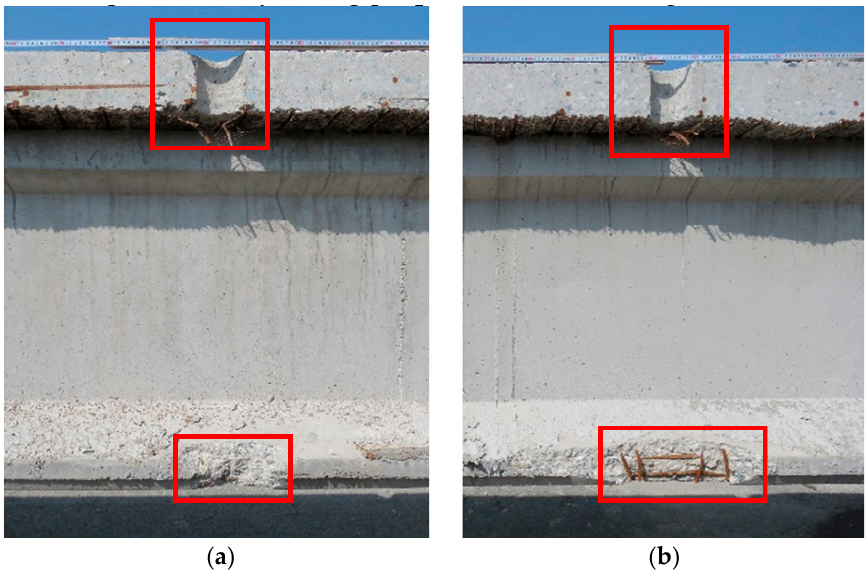
Figure 5. Typical damage due to lifting operations: ( a ) damage at 4 m and ( b ) damage at 15 m from the beginning of the PC girder.